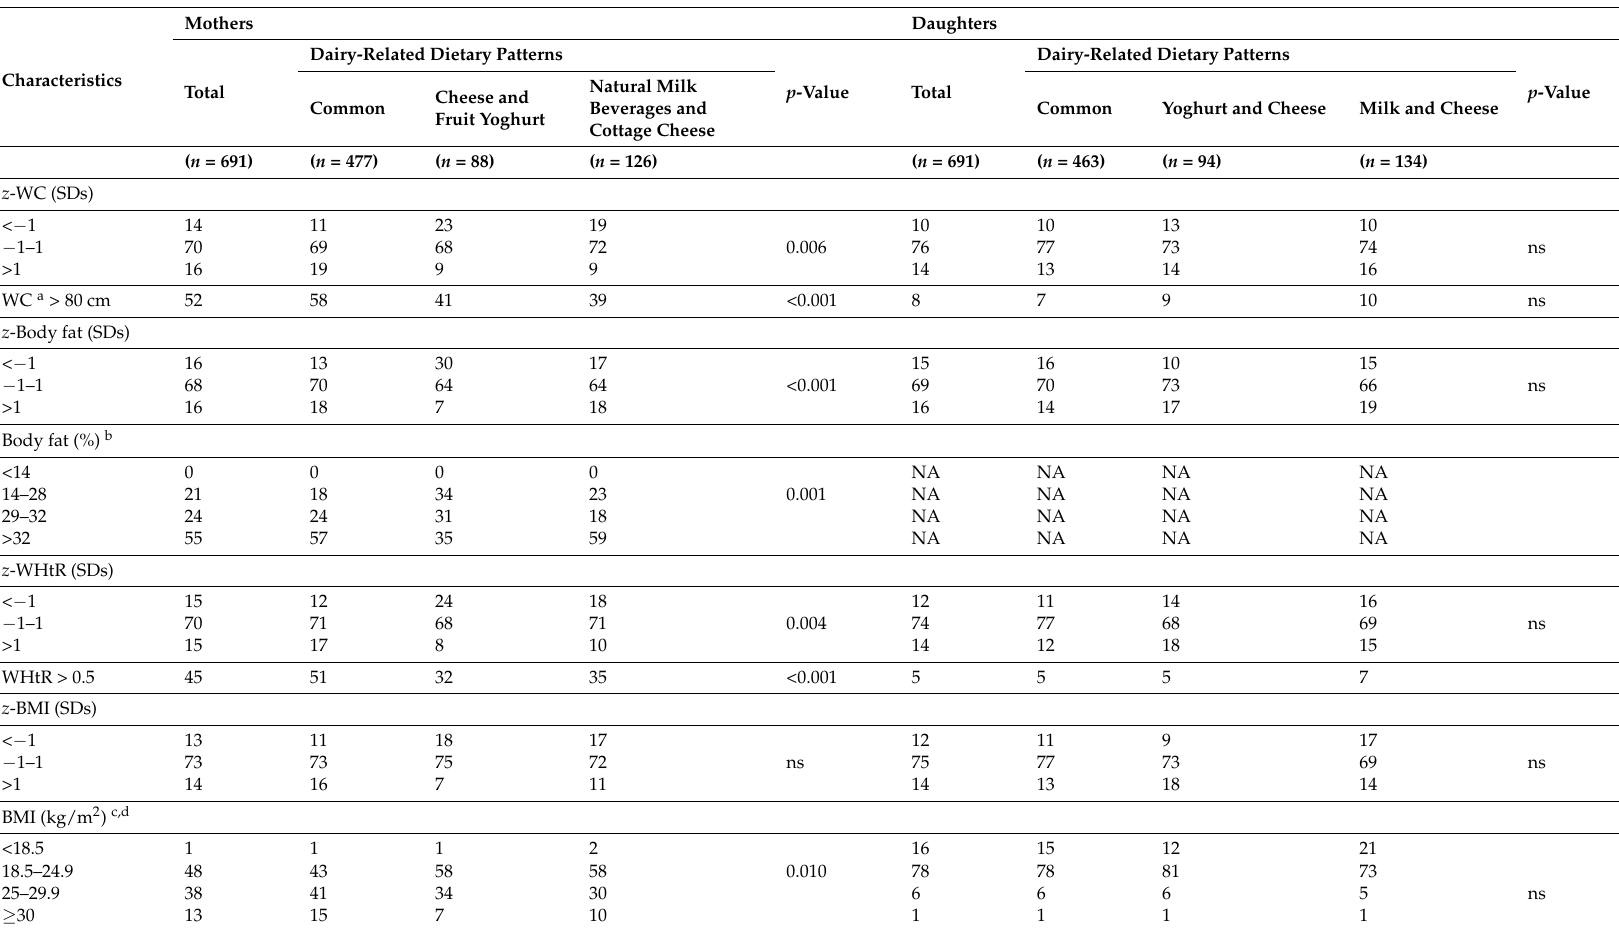
Table 2. Distributions (%) of body weight and composition characteristics by dairy-related dietary